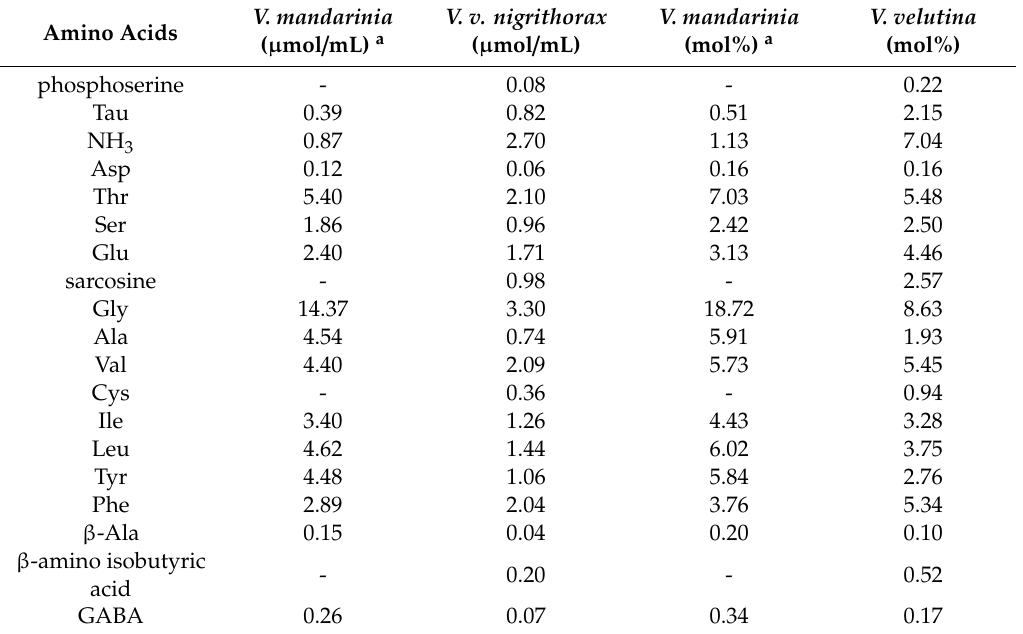
Table 2. Physiological amino acid compositions of larval saliva of V. v. nigrithorax compared to V.